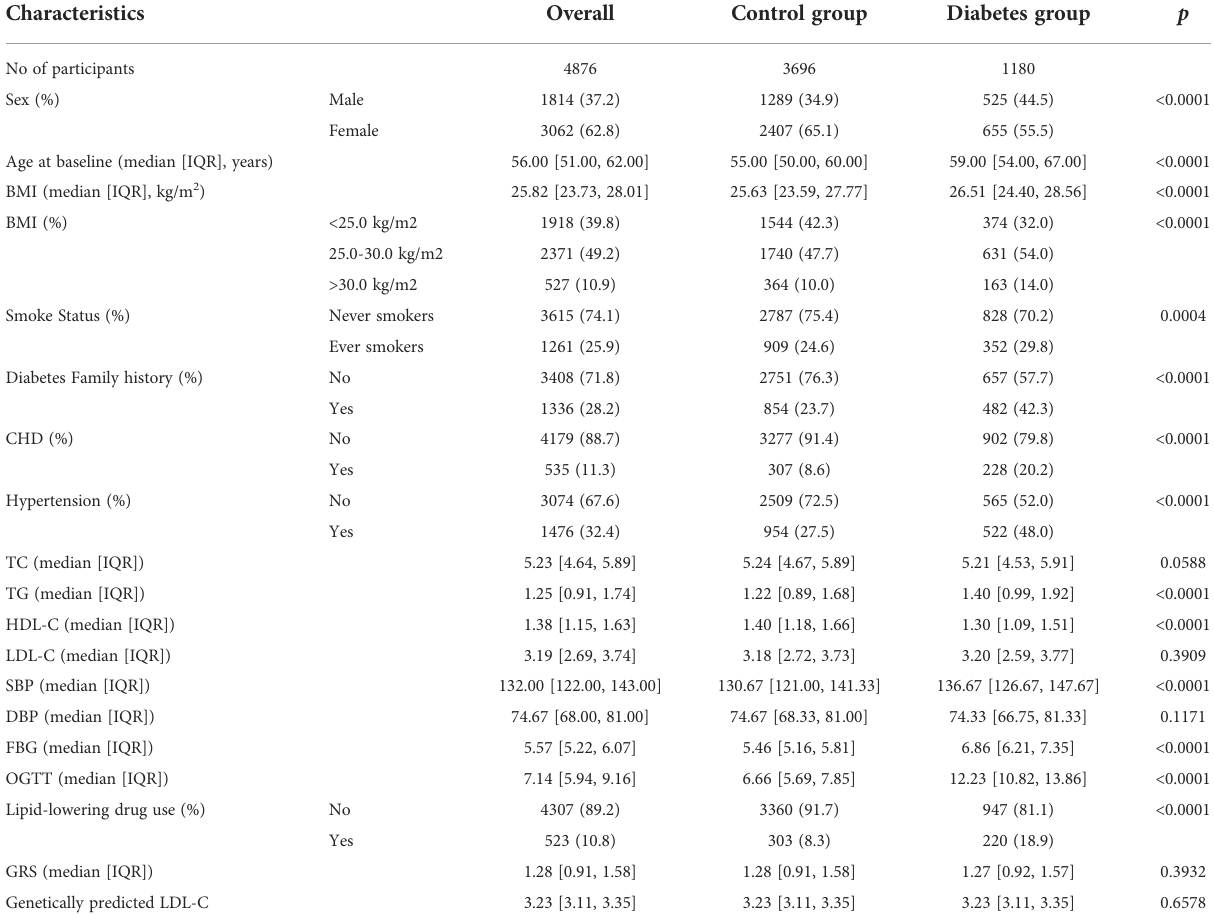
TABLE 1 Summary demographic information of participants in observational analysis.